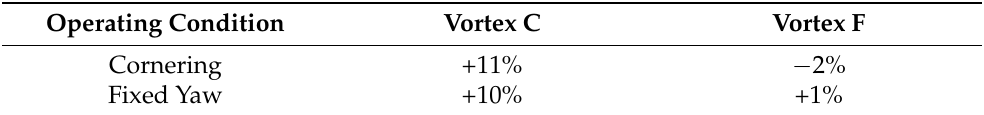
Table 4. A table showing the change in strength of the inboard flap tip vortices at x Wi /c = 1.624 under the cornering and fixed yaw conditions relative to the straight-line